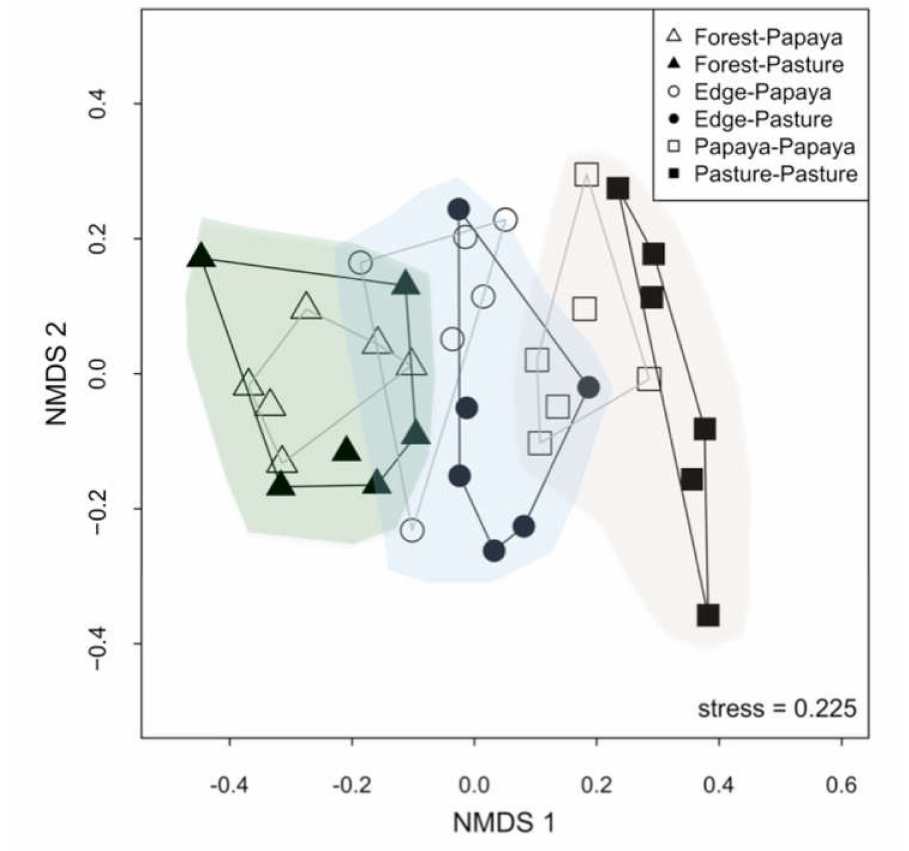
Figure 3. Non-metric multidimensional scaling (NMDS) with ordination based on Bray–Curtis dissimilarities to compare vegetation types by site category. Triangles represent forest interiors, circles represent forest edges, and squares represent agricultural land. Black-filled symbols represent vegetation types at papaya site category and empty symbols represent vegetation types at cattle pasture site category. Green shadow highlights forest interior, light blue shadow highlights forest edge, gray shadow highlights agricultural land. Vegetation types drives separation in replicates along the first